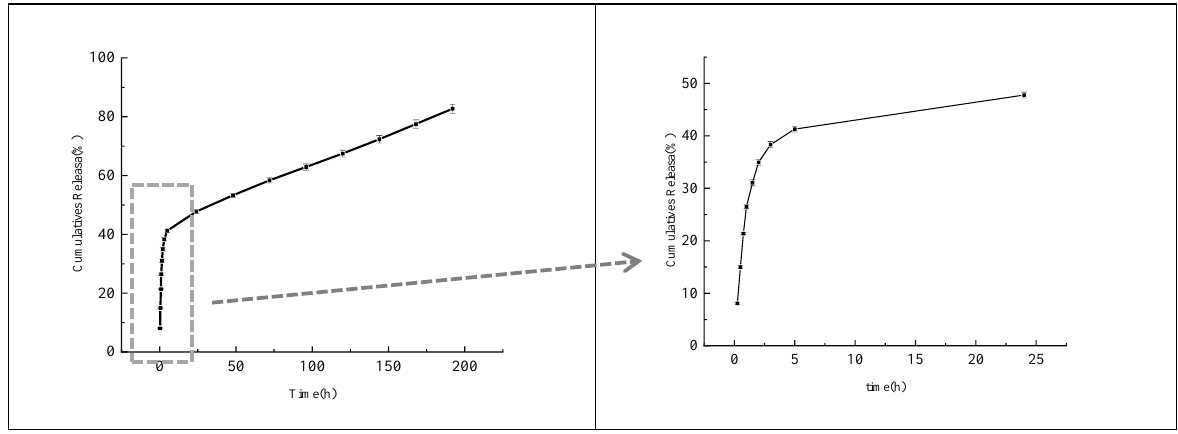
Figure 8. In vitro release profile in saline-phosphate buffer with sodium lauryl sulfate, pH 7.4, from optimized OEO-CSNPs. Data were represented as mean ± SD, n = 3.